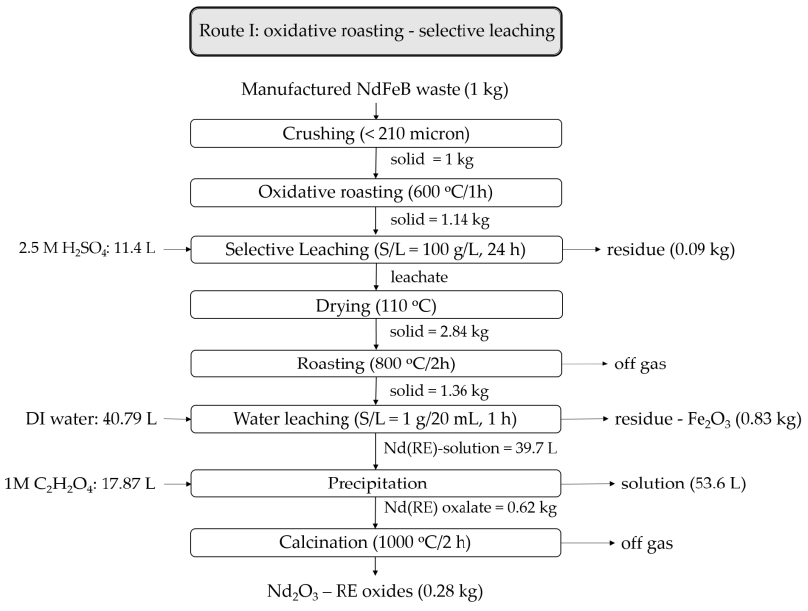
Figure 14. The material balance of sintered NdFeB recycling under route I: oxidative roasting and selective leaching.